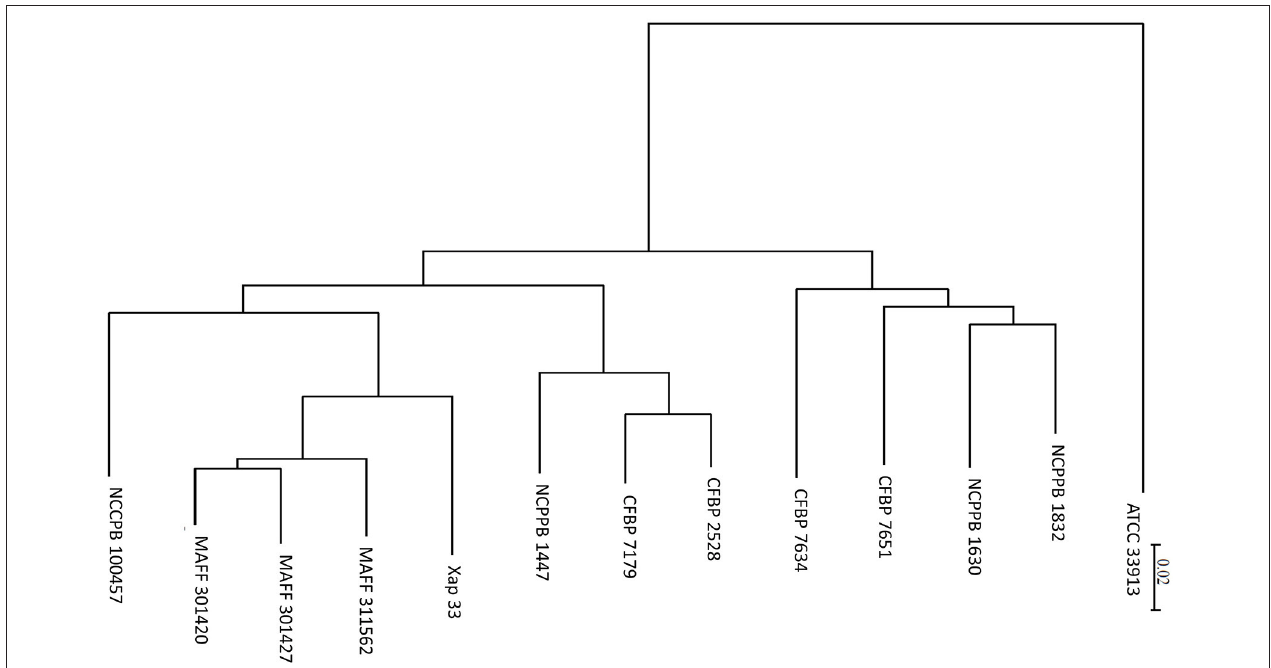
FIGURE 3 | CVTree obtained from X. arboricola genome sequences available in public database. Xanthomonas campestris pv campestris (ATCC 33913); Xanthomonas arboricola pv celebensis (NCPPB 1832, NCPPB 1630); Xanthomonas arboricola (CFBP 7651, CFBP 7634); Xanthomonas arboricola pv juglandis (NCPPB 1447, CFBP 2528, CFBP 7179); Xanthomonas arboricola pv pruni (Xap 33, MAFF 311562, MAFF 301427, MAFF 301420); Xanthomonas arboricola pv corylina (NCCPB 100457). Branch length represents the distance calculated using alignment free composition vector